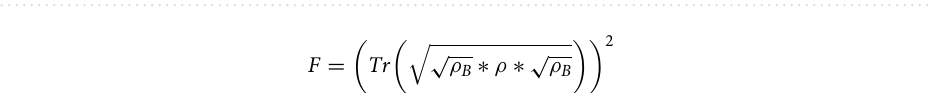
Figure 5. Fidelity to the Bell states and concurrence of the density matrix obtained after the compensation scheme as a function of temporal detuning δt in case of a perfect compensation of the